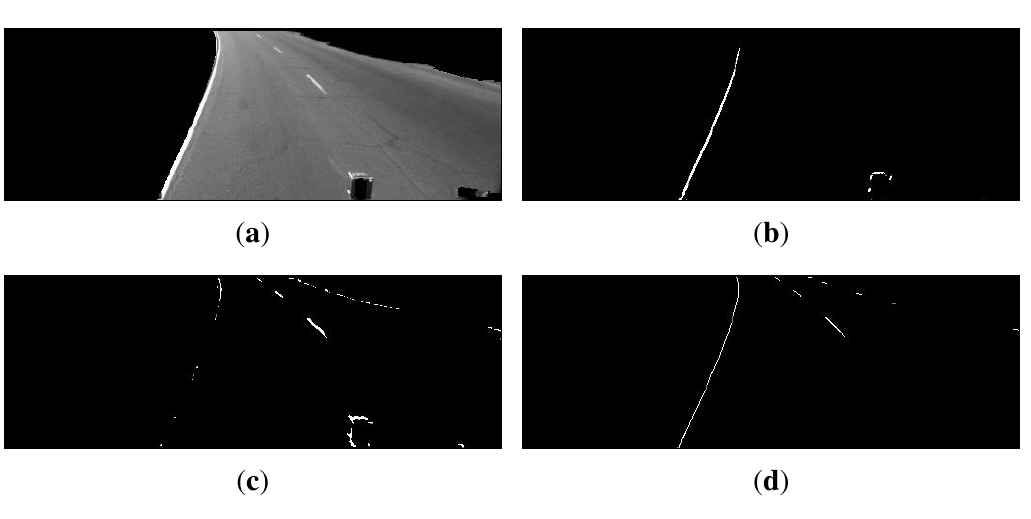
Figure 3. Application of steerable filters, and the edge length and eccentricity selection criteria to a road image of the Caltech Lanes dataset [45]. ( a ) Segmented road area using after thresholding; ( c ) Response Gabor textures; ( b ) Response to steerable filter with θ = − Π 6 to steerable filter with θ = + Π after thresholding; ( d ) Logical “or” operation of ( b ) and ( c ), 6 and posterior edge selection based on the segment length and eccentricity